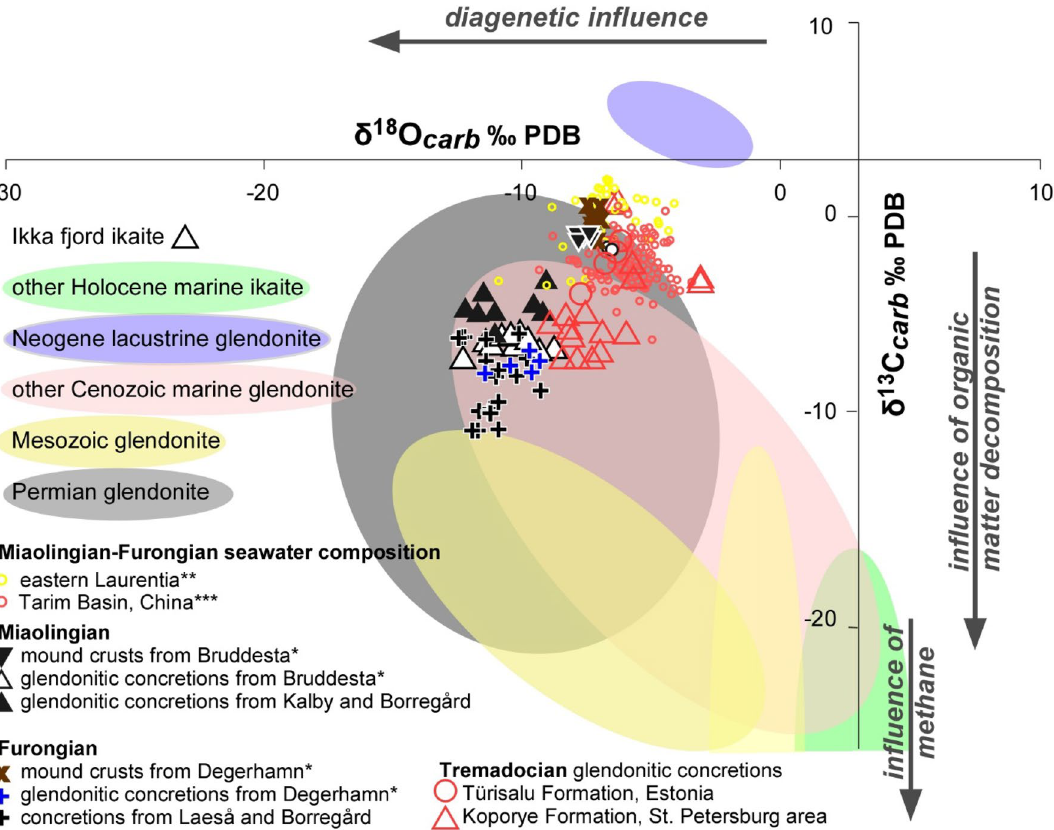
Figure 6. Stable isotope dataset plot for mound crusts and glendonitic concretions from the Miaolingian (including concretions from Kalby and Borregård 22 ), Furongian (adding concretions from Laeså and Borregård 22 ) and Tremadocian 31,32 of the Baltoscandian Basin; shaded areas 33–36 ; asterisk: new data from Repository Data; double asterisk: comparative data from Laurentia, and triple asterisk: from China 37,38 phase (liquid + vapour) FI with liquid percentages about 95%. The all-liquid FI nucleate a bubble inside with cooling. All FI freeze at temperatures ranging from ‒ 52 to ‒ 74 °C, usually around ‒ 60 °C ( T n ). Upon reheating, the first melting temperature ( T fm ) is observed at ‒ 67 to ‒ 50 °C, and the final melting of ice ( T mice ) at ‒ 23.7 to ‒ 11.2 °C. FI homogenization ( T h ) occurs to the liquid usually from 59 to 85 °C. The low T fm of the measured FIAs indicates the presence of bivalent cations being close to the eutectic temperature of the H 2 O–NaCl–CaCl 2 system 39 . The fact that both ca1 and ca2 share FIAs with similar T fm , T mice and T h suggests that ca1 recrystal- lized under the same fluid that precipitated ca2 , probably infilling the primary porosity yielded by the ikaite- ca1 transformation. In the absence of pressure estimates, these T h can be interpreted as a minimum entrapment temperature 40 , providing a minimum temperature for ca2 precipitation and ca1 recrystallization. Fissures occluded with ca3 mosaics contain another type of FIAs. They are primary to the fracture filling, as manifested by their long axis aligned to the direction of the fracture. Their size ranges from 20 to 70 µm, and are all-liquid or all-gas or very rich in gas. In the FI with enough liquid, the freezing ( T fm ) occurs between ‒ 44 and ‒ 40 °C, the first melting around ‒ 21 °C and the T mice between 2.3 and ‒ 1.8 °C. T fm ‒ 21 ºC is indicative of a H 2 O–NaCl system 40 , and salinities being 3.06 ‒ 3.87 NaCl wt% equivalent 39 . Sulphur isotope signatures of polymetallic sulphides. As stated above, the basal lags of the metallif- erous carbonate mounds display accumulations of hydrothermal sulphides sourced from the veins affecting the lower calcite crusts and sealed (so post-dated) by the upper calcite crusts. Pyrite occurs as single euhedral grains and framboids (up to 20 ‒ 100 µm in diameter), in some cases forming centimetre-sized pockets. Galena occurs as subhedral to anhedral grains with interstitial pyrite and sphalerite inclusions. Analyses of the four stable sulphur isotopes ( 32 S, 33 S, 34 S and 36 S; Suppl. Table 3) from the polymetallic sul- phides encased in the A. pisiformis Zone of the Kakeled Limestone Bed at Bruddesta yielded δ 34 S values ranging from ‒ 2.08 to ‒ 9.33 ‰, with ∆ 33 S [= ( 33 S/ 32 S) sample /( 33 S/ 32 S) reference − (( 34 S/ 32 S) sample /( 34 S/ 32 S) reference ) 0.515 ] ranging from 0.014 to 0.103 (Fig. 7). Among different sulphur species, two galena samples display the most 34 S-enriched values (δ 34 S: ‒ 2.08 ‰ and ‒ 3.56 ‰) and minimal ∆ 33 S values (0.014 and 0.036), respectively. The framboidal pyrites exhibits the most 34 S-depleted value (δ 34 S: ‒ 9.33‰) with ∆ 33 S of 0.068 (Fig. 7; Suppl. Table 3).